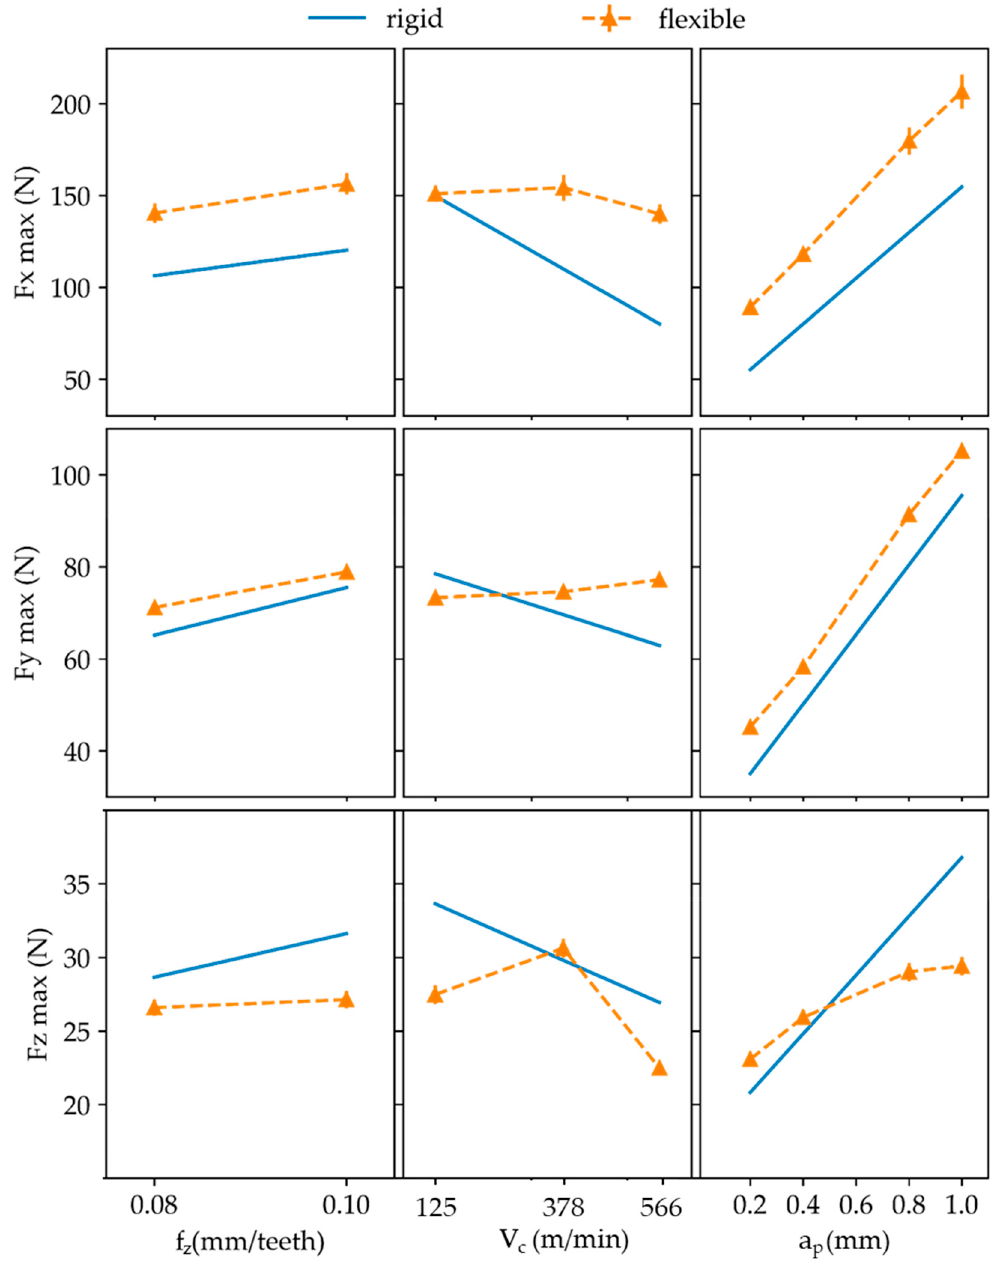
Figure 7. Average forces for the x , y and z axes under rigid (solid blue line) and flexible (dashed orange line) consideration.